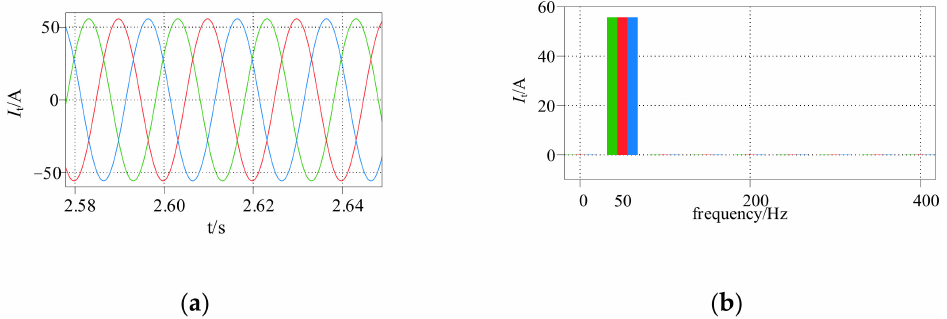
Figure 7. ( a ) Current curve of a GFM converter ( P set = 25,000 W, SCR = 4.84); ( b ) current THD of a GFM converter ( P set = 25,000 W, SCR = 4.84). (Green for phase A, red for phase B, blue for phase